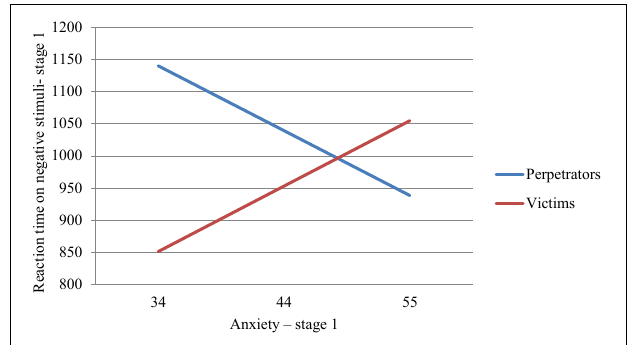
FIGURE 3 | The moderation effect of the role in accident on the relation between anxiety and reaction time on negative stimuli.